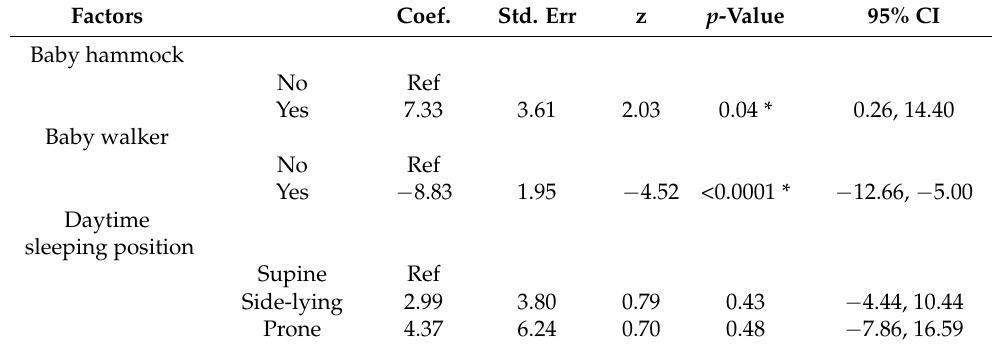
Table 4. Factors affecting gross motor percentile (multivariate